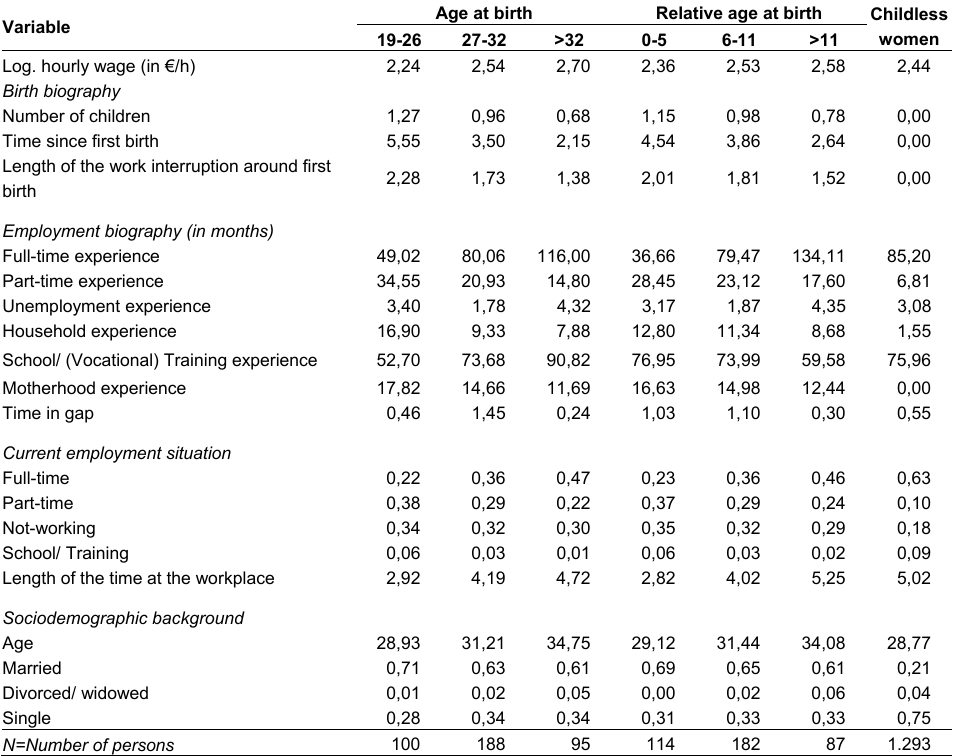
Mean values of the used variables by the age at first birth and the relative